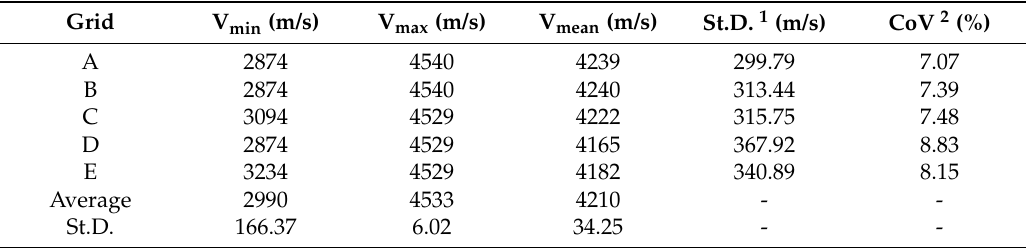
Table 2. Summary of UT measurements.